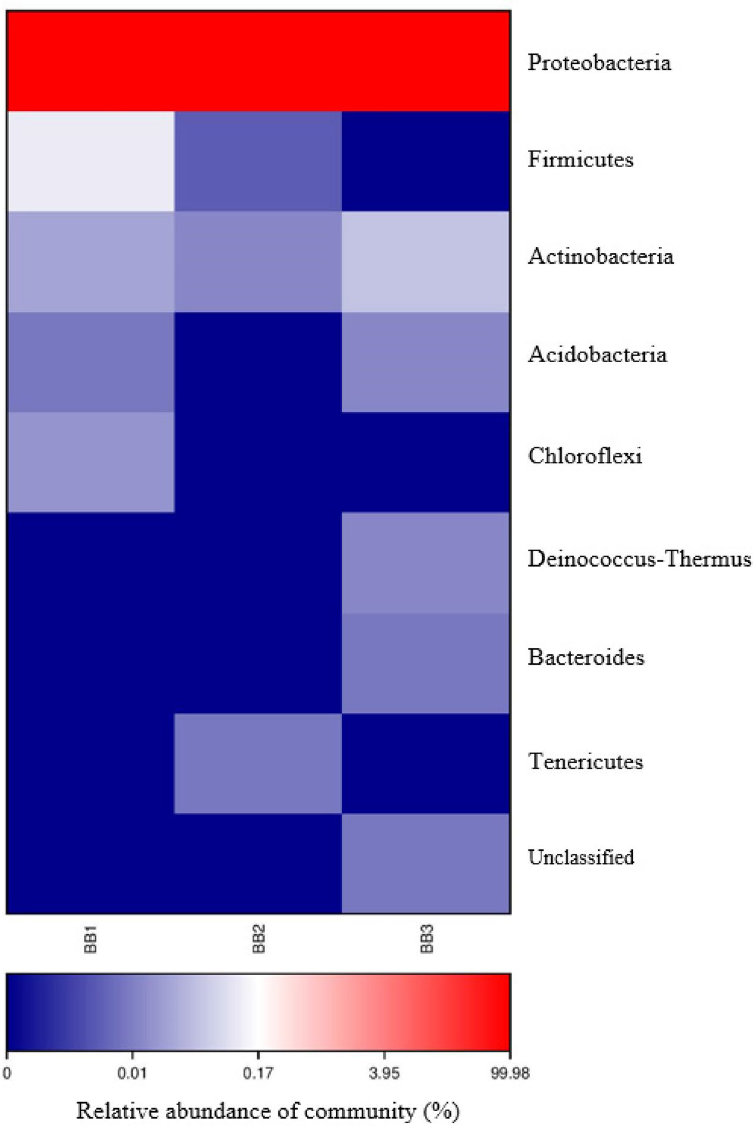
Figure 4. Heatmap analysis of three samples, BB1, BB2 and BB3 from blood-fed bed